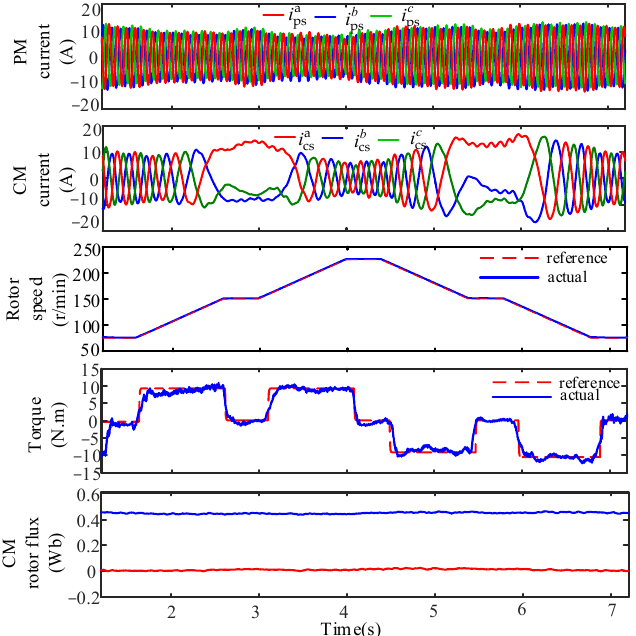
Figure 17. Experimental results of step increase speed and step decrease speed.